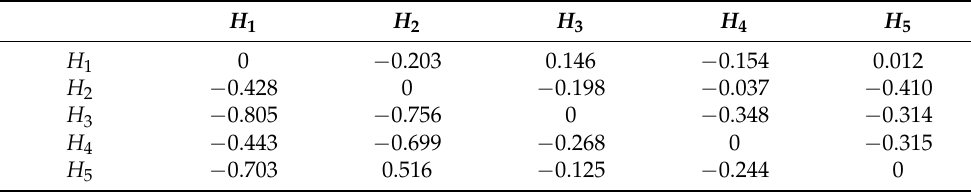
Table 5. Combined perceived value function values H i for scenario relative H v